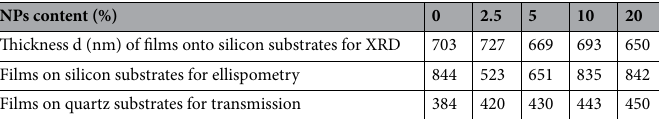
Table 3. The correlations between temperature dependences of thickness and ellipsometric angles were presented in